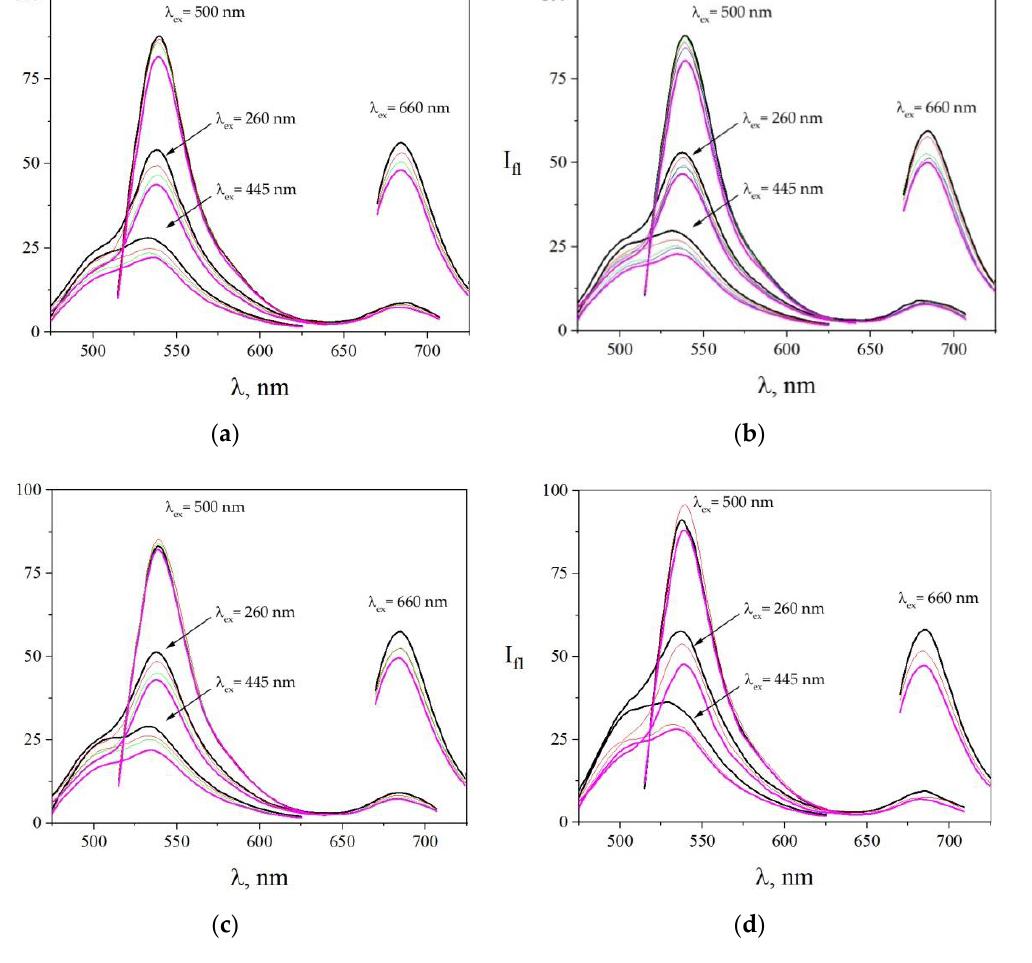
Figure 5. The spectra of the fluorescent probe array after adding heavy metal ions to a solution, subject to excitation at various wavelengths from 260 to 660 nm. ( a ) In the case of [Cd 2+ ], the concentrations of the salt were C Cd(NO3)2 = 0 M (black line), C Cd(NO3)2 = 1.17 × 10 − 8 M (red line), C Cd(NO3)2 = 3.31 × 10 − 8 M (green line), and C Cd(NO3)2 = 5.2 × 10 − 8 M (purple line). ( b ) In the case of [Zn 2+ ], the concentrations of the salt in the solutions were C Zn(NO3)2 = 0 M (black line), C Zn(NO3)2 = 1.46 × 10 − 6 M (red line), C Zn(NO3)2 = 2.83 × 10 − 6 M (green line), C Zn(NO3)2 = 4.11 × 10 − 6 M (blue line), and C Zn(NO3)2 = 6.46 × 10 − 6 M (purple line). ( c ) In the case of [Cs + ], the concentrations of the salt were C CsCl = 2.11 × 10 − 6 M (black line), C CsCl = 2.11 × 10 − 6 M (red line), C CsCl = 5.94 × 10 − 6 M (green line), and C CsCl = 9.33 × 10 − 6 M (purple line). ( d ) In the case of various volumes of distilled water: 0 (black line), 1/30 of initial volume (red line), and 5/30 of initial volume (purple line). The excitation wavelengths are shown in the